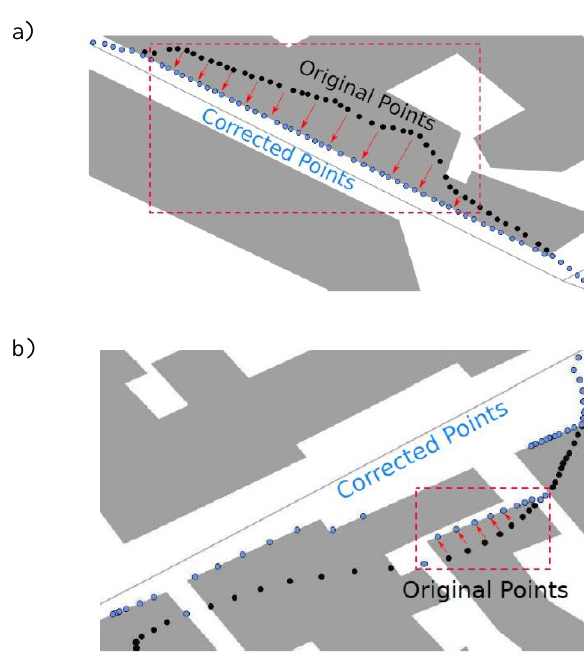
Figure 8 . Cartographic correction of GNSS